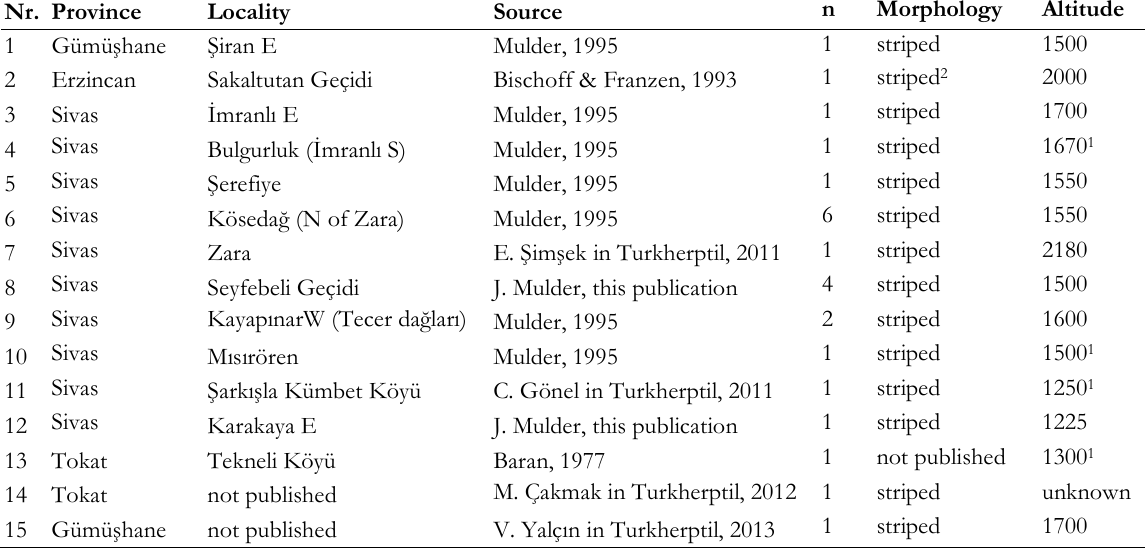
Table 1. Compilation of all records containing data on locality, altitude or